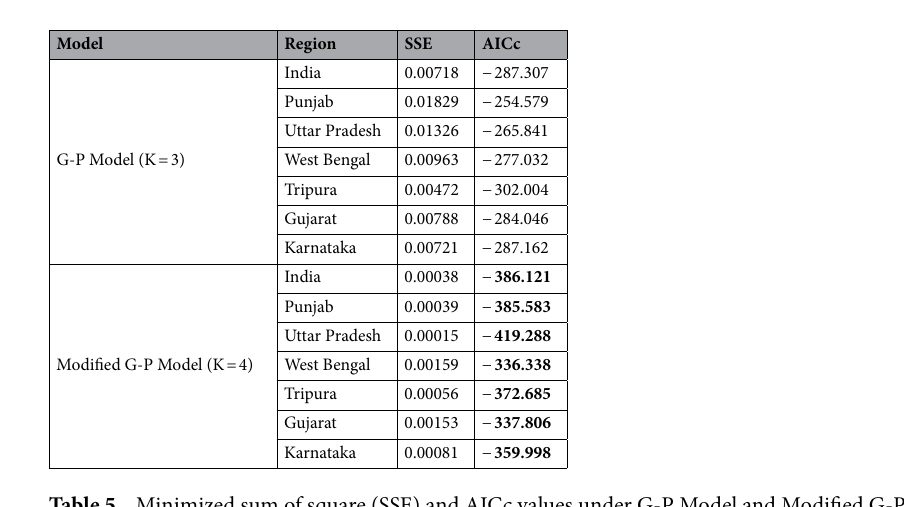
Table 5. Minimized sum of square (SSE) and AICc values under G-P Model and Modified G-P Model for India and 6 selected states. The least value of AICc is written in the bold case for each